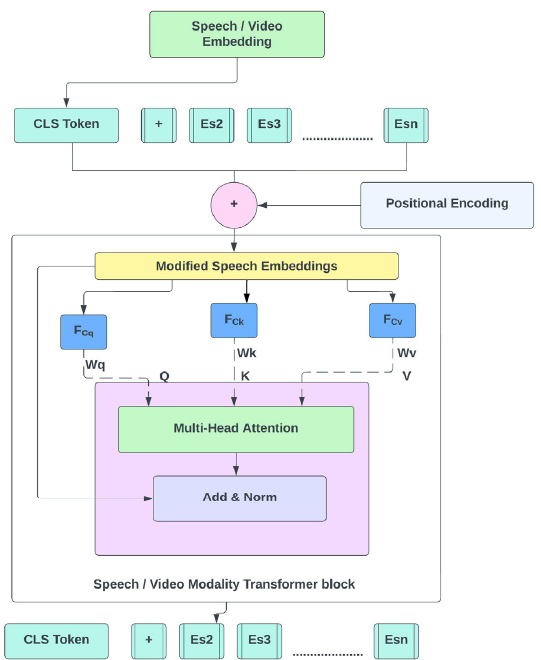
Figure 3. Transforming speech and video during the embedding process.